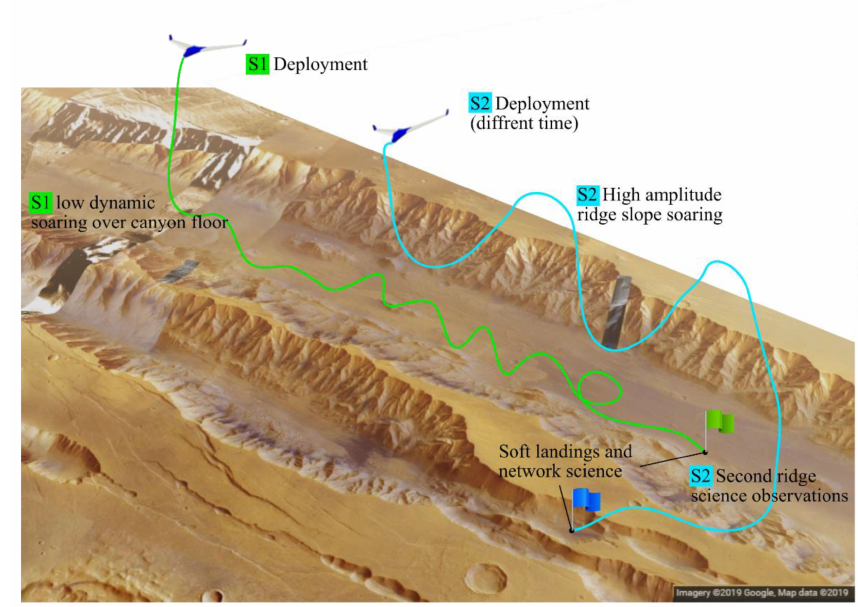
Figure 1. Concept of operations of sailplanes S1 and